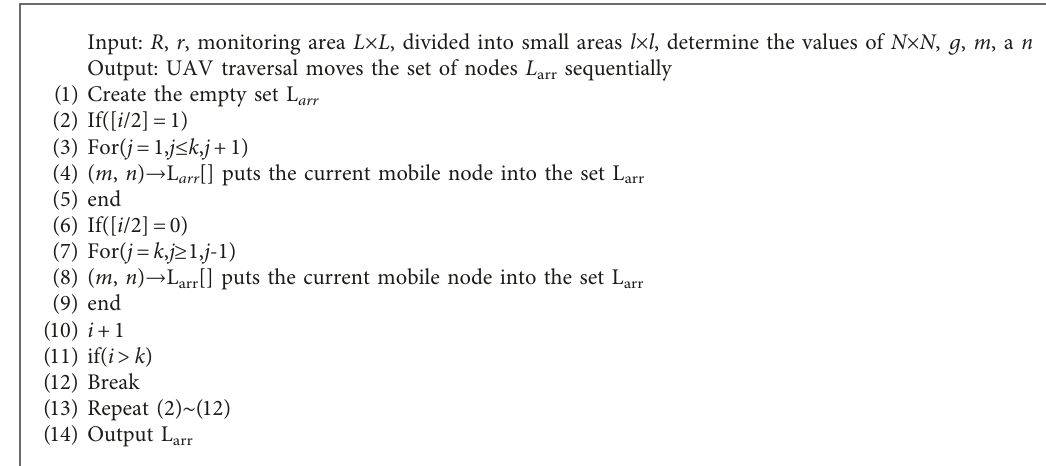
A LGORITHM 1: Algorithm of UAV